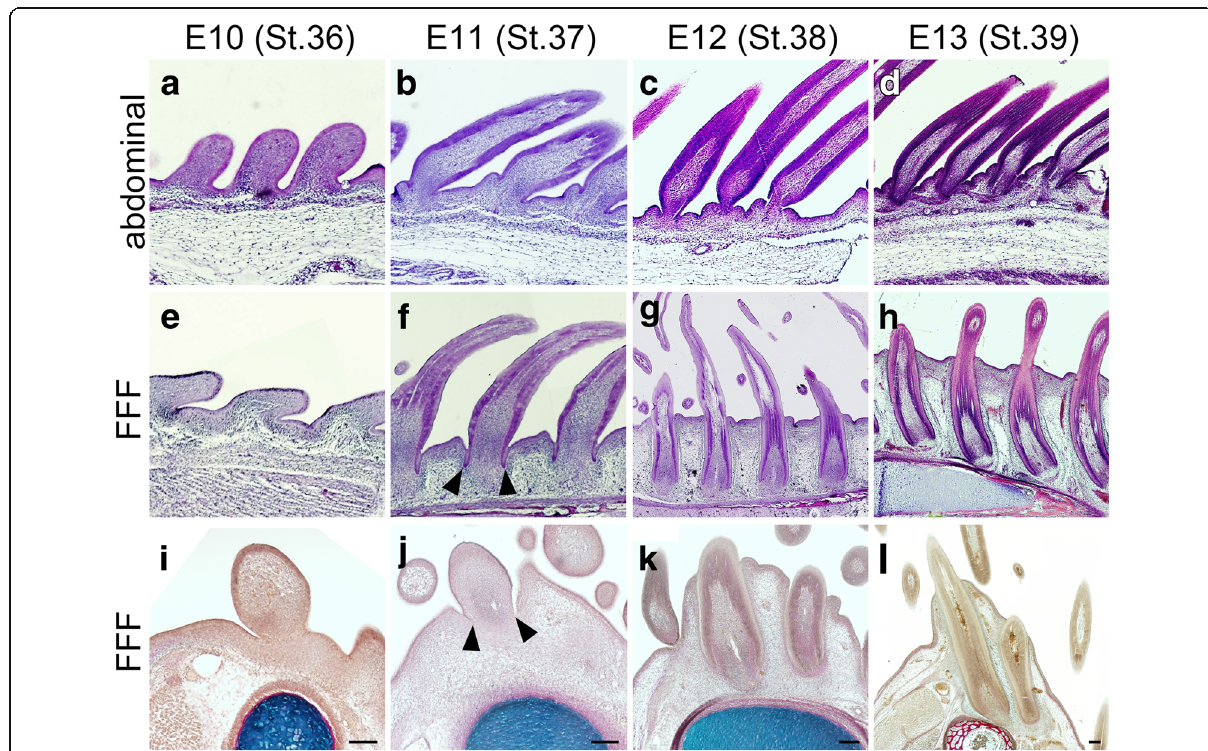
Fig. 5 Deep invagination of the feather bud toward the bone primordium in the FFF region. a – h Sagittal sections of abdominal skin ( a – d ) and coronal sections of the FFF region ( e – h ) at E10 ( a , e ), E11 ( b , f ), E12 ( c , g ) and E13 ( d , h ). Arrowheads in ( f ) indicate the follicular cavity that starts invagination. i – l . Transverse sections of the FFF region showing the invagination process of the feather bud in the FFF region at E10 ( i ), E11 ( j ), E12 ( k ) and E13 ( l ). Scale bars: 100 μ m. The blue core is the cartilaginous rudiment of the ulna, and the red layer surrounding the ulna cartilage